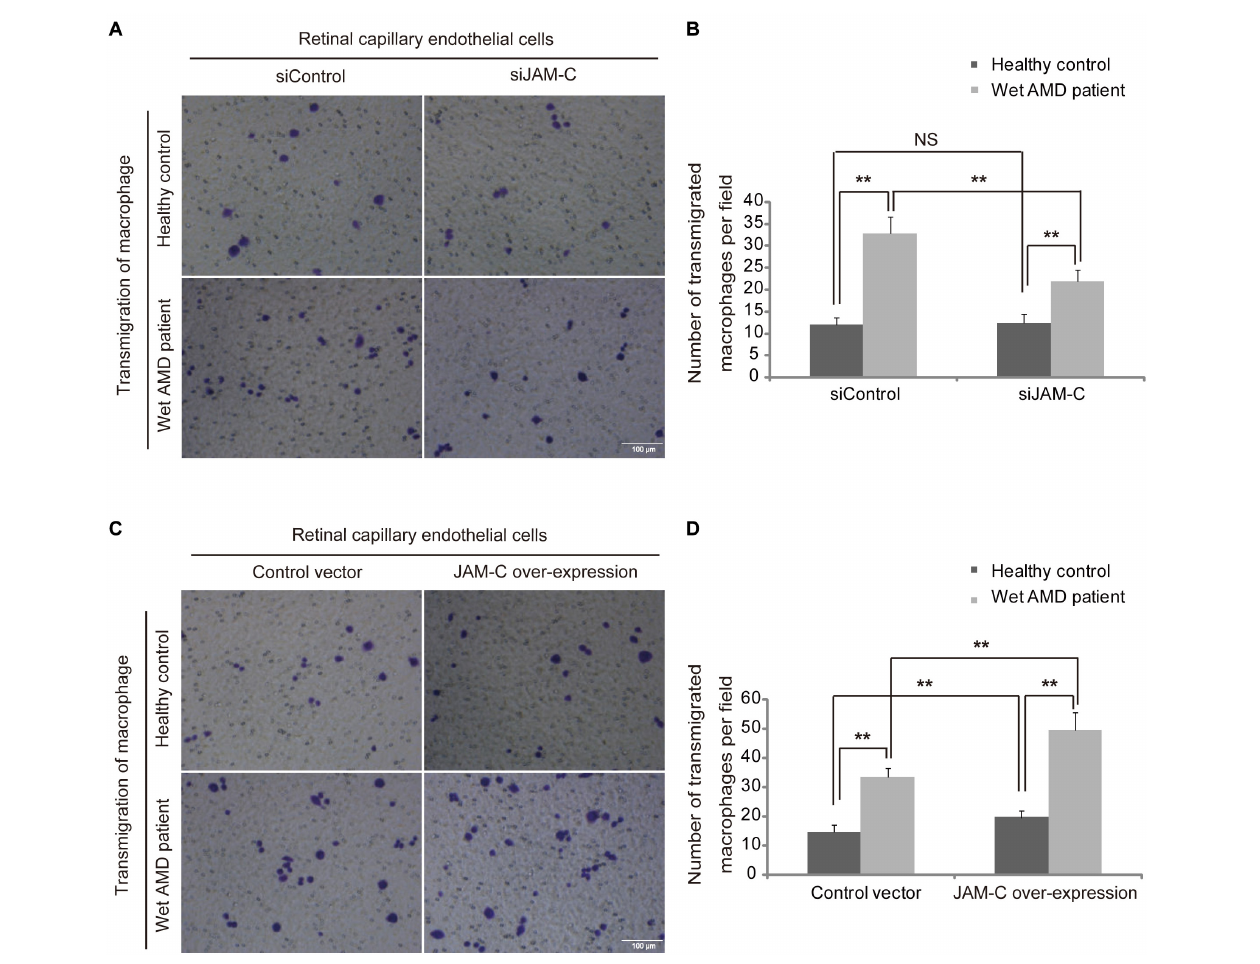
FIGURE 5 | JAM-C regulates macrophage transmigration through human RCECs. RCECs were cultured to confluence on the upper layer of a permeable membrane, and then macrophages were placed on the upper chamber and allowed to migrate through the RCEC monolayer to the lower chamber for 4 hr. Transmigrated macrophages were counted in five random fields. (A,B) JAM-C knockdown inhibited the transmigration of macrophages from wAMD patients, but not those from healthy controls. The transmigration of macrophages from wAMD patients in both the siControl and siJAM-C groups increased compared to those from healthy controls. (C,D) JAM-C overexpression increased the transmigration of macrophages from both wAMD patients and healthy controls. The transmigration of macrophages from wAMD patients in both the control and JAM-C overexpression groups increased compared to those from healthy controls. Scale bar: 100 µ m, ** P < 0.01, NS, not